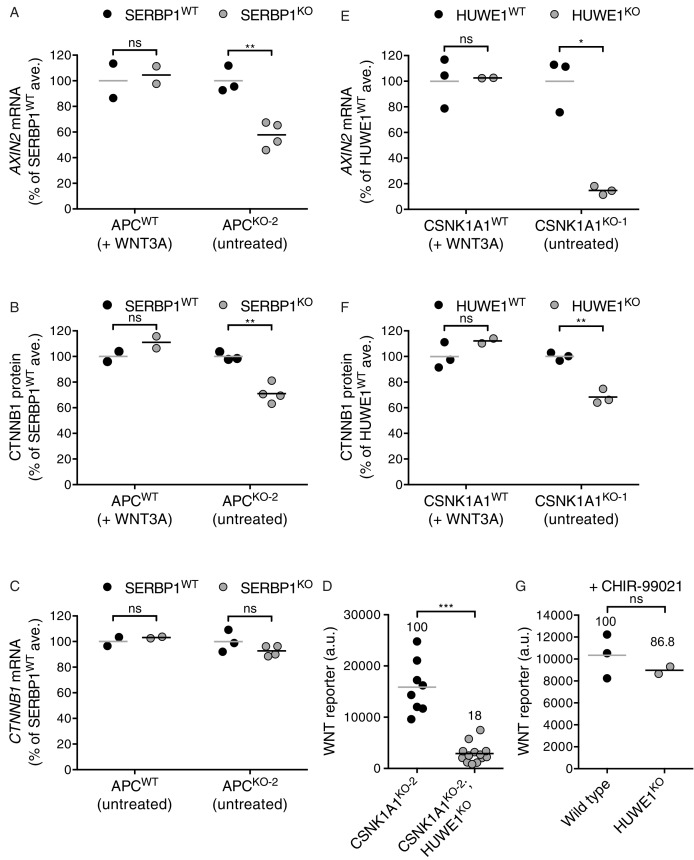
The mRNA binding protein SERBP1 controls CTNNB1 abundance in cells lacking APC (A–C), and the E3 ubiquitin ligase HUWE1 regulates WNT signaling in the absence of CSNK1A1 (D–G).(A) AXIN2 mRNA (average AXIN2 mRNA normalized to HPRT1 mRNA, each measured in triplicate reactions) for SERBP1WTand SERBP1KO genotypes in APCWTand APCKO-2 genetic backgrounds, expressed as percentage of the average for SERBP1WT cells to facilitate comparisons. Cells were treated with 50% WNT3A CM where indicated. Each circle represents a unique clonal cell line and the average of two to four independent clones for each genotype is indicated by a horizontal line. The cell lines used in A were also analyzed in B and C. In all panels of this figure, significance was determined by unpaired t-test with Welch’s correction and is indicated as ***(p<0.001), **(p<0.01), *(p<0.05) or ns (not significant). (B) CTNNB1 protein (average CTNNB1 intensity normalized to ACTIN intensity from duplicate blots) expressed as percentage of the average for SERBP1WT cells. Cells were treated with 50% WNT3A CM where indicated. (C) CTNNB1 mRNA (average CTNNB1 mRNA normalized to HPRT1 mRNA, each measured in triplicate reactions) expressed as percentage of the average for SERBP1WT cells. (D) WNT reporter activity (median EGFP fluorescence from ~10,000 cells in a.u.). Each circle represents a unique clonal cell line and the average of ≥8 independent clones for each genotype is indicated by a horizontal line. The percentage reporter activity relative to control cells is also indicated above each group of circles. (E) AXIN2 mRNA (average AXIN2 mRNA normalized to HPRT1 mRNA, each measured in triplicate reactions) for HUWE1WTand HUWE1KO genotypes in CSNK1A1WTand CSNK1A1KO-1 genetic backgrounds, expressed as percentage of the average for HUWE1WT cells to facilitate comparisons. Cells were treated with 50% WNT3A CM where indicated. Each circle represents a unique clonal cell line and the average of two to three independent clones for each genotype is indicated by a horizontal line. The cell lines used in E were also analyzed in F and G. (F) CTNNB1 protein (average CTNNB1 intensity normalized to ACTIN intensity from duplicate blots) expressed as percentage of the average for HUWE1WT cells. Cells were treated with 50% WNT3A CM where indicated. (G) WNT reporter activity (median EGFP fluorescence from 20,000 cells) for WT and HUWE1KO cells (in a CSNK1A1WT genetic background) following treatment with 10 μM of the GSK3 inhibitor CHIR-99021. The percentage of reporter activity relative to WT is also indicated above the circles.